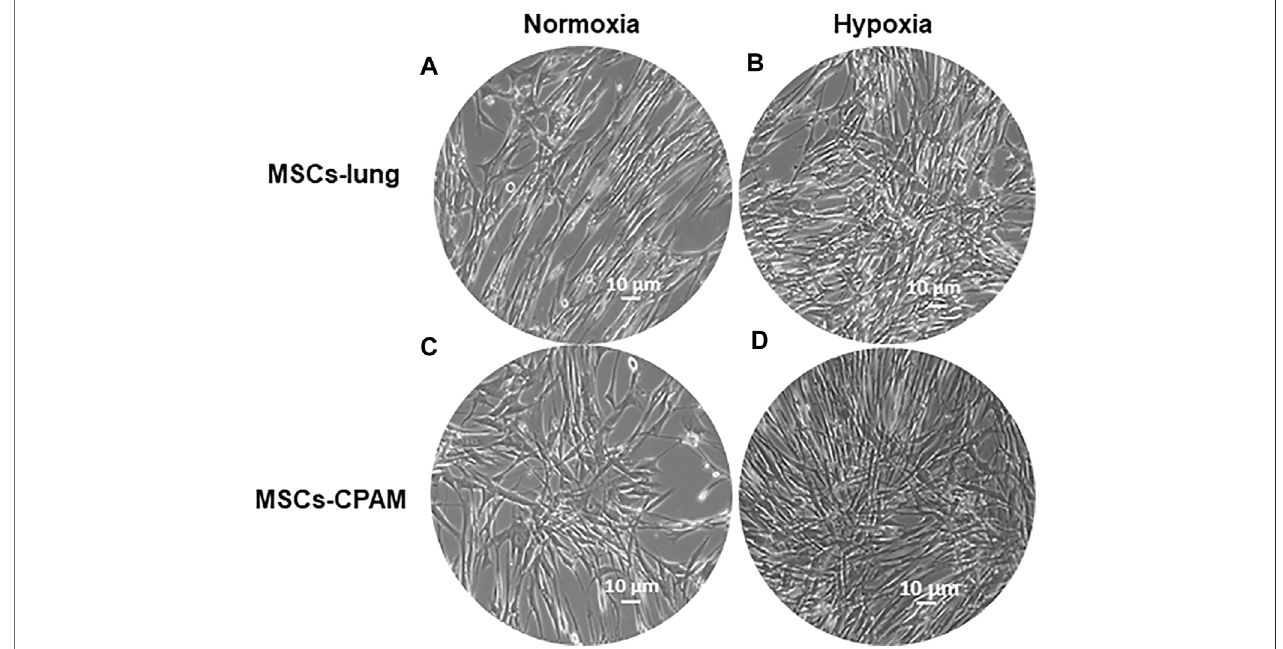
FIGURE 1| MSCs-lung and MSCs-CPAM morphology observations under inverted light microscopy. (A,C) Normoxic controls. (B,D) Hypoxia samples. Scale bar = 10